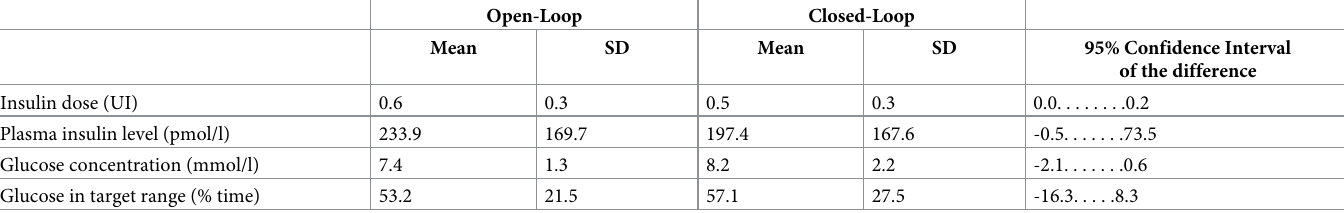
Table 2. Descriptive statistics for the average insulin administration dose and plasma insulin and glucose levels in open- and closed-loop (N =